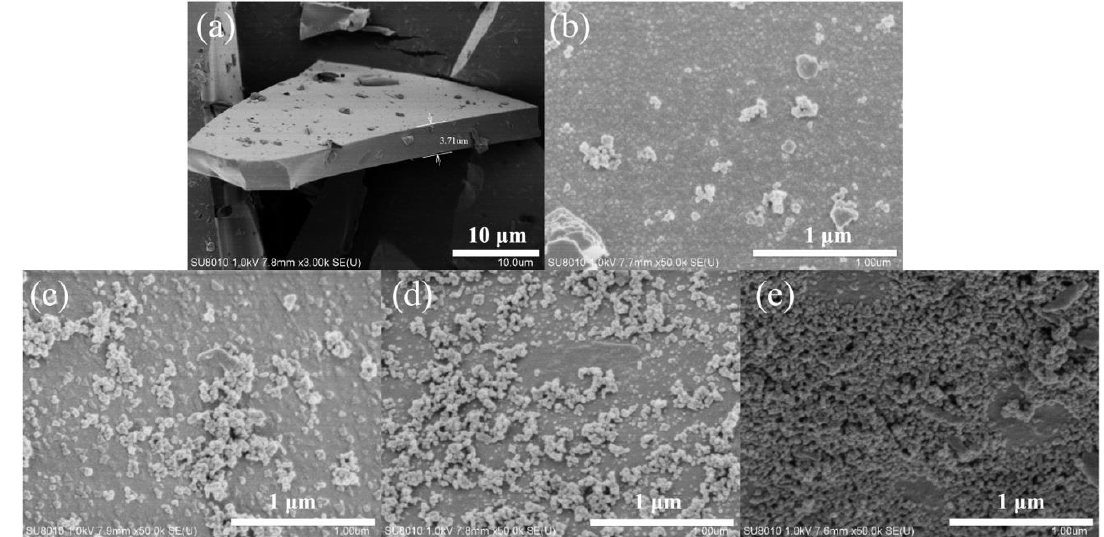
Figure 1. SEM images of ( a ) unmodified basalt flakes (BFs) and BFs modified with ( b ) 1 ‰ , ( c ) 3 ‰ . ( d ) 5 ‰ , and ( e ) 7 ‰ nano-SiO 2 microspheres.